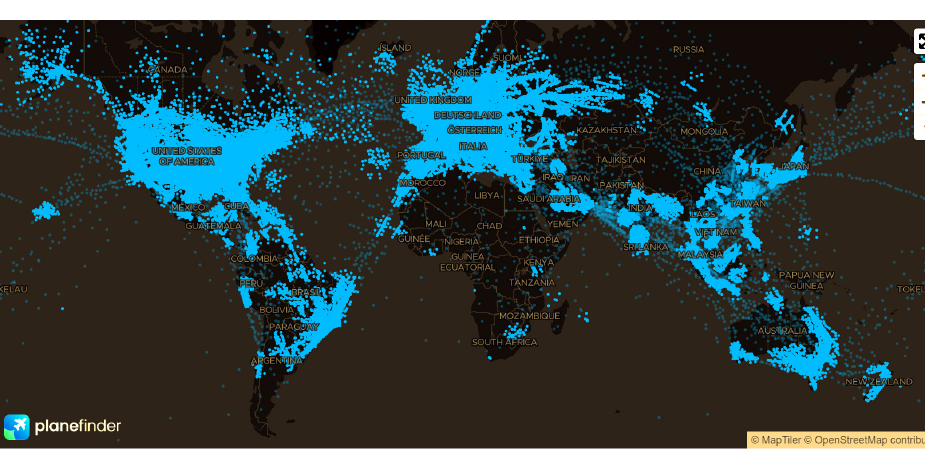
Fig. 4. A screenshot of an interactive airspace map monitored by Planefinder